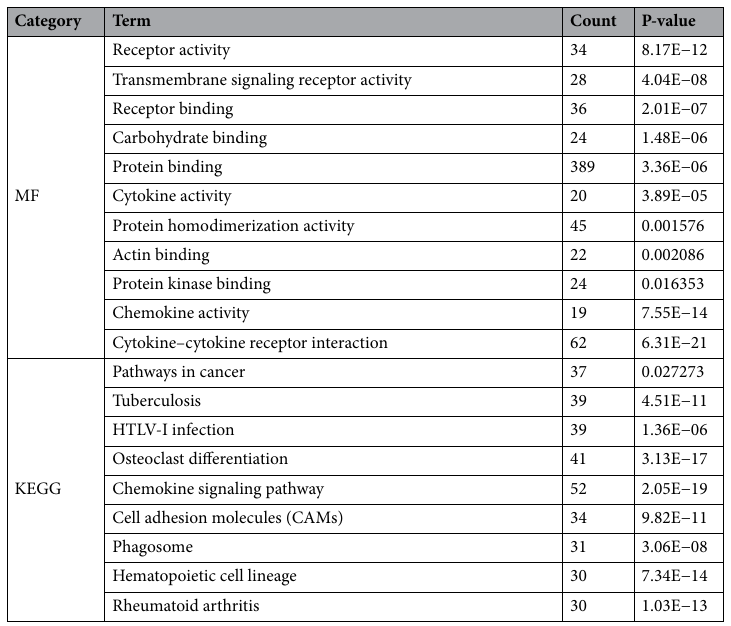
Table 2. The gene ontology and pathway enrichment of DEGs of